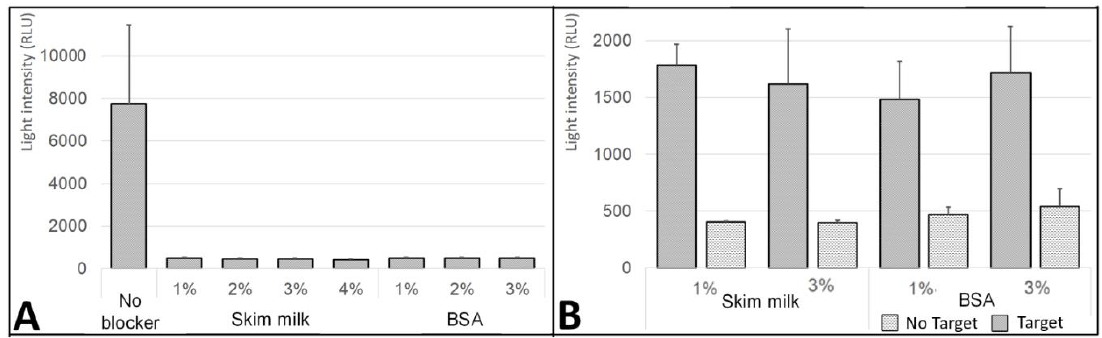
Figure 5. Effect of the blocking step on the DNA nonspecific absorption on the glass surface. The blocking treatment was conducted on the silver-modified glass surfaces, with either bovine serum albumin (BSA) or skim milk. Then, the light signal was compared with the untreated (without blocking agent) glass tubes. After the blocking step, all the tubes were incubated for 1 h with 20 µL 1 µM of the reporter DNA strand linked to horseradish peroxidase (HRP). The light signal was measured after washing, by adding a mixture of 1:1 ( v / v ) H 2 O 2 + luminol solution (HRP substrate). ( A ) Glass tubes without immobilized surface DNA. ( B ) The effect of the blocking step on the annealing processes was examined by conducting the blocking treatment on glass tubes with immobilized